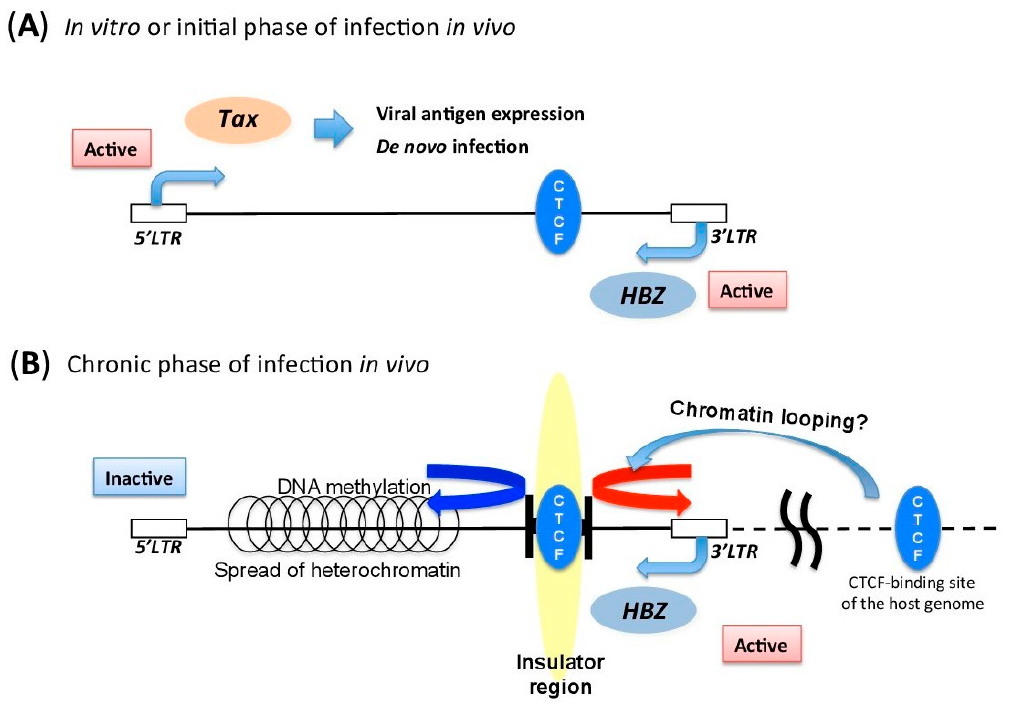
Schematic figure of mechanisms regulating HTLV ‐ 1 provirus, in vitro and in vivo . ( A ) Schematic figure of HTLV ‐ 1 provirus in vitro or during the initial phase of infection in vivo. Tax and viral structural proteins can be expressed, because there is little immune surveillance against the viral antigens. ( B ) Schematic figure of HTLV ‐ 1 provirus during the chronic phase of infection in vivo . HTLV ‐ 1 maintains a distinct transcription pattern between 5 ′ long terminal repeat (LTR) and 3 ′‐ LTR by recruiting the host insulator protein CTCF. The insulator region of HTLV ‐ 1 provirus is thought to prevent the spread of heterochromatin from 5 ′‐ LTR to 3 ′‐ LTR. This could also induce chromatin looping with the host’s CTCF ‐ binding sites.